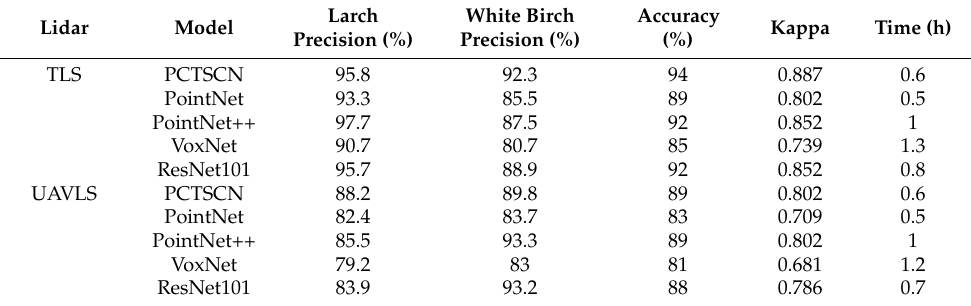
Table 7. Classification performance of various deep learning model tree species.